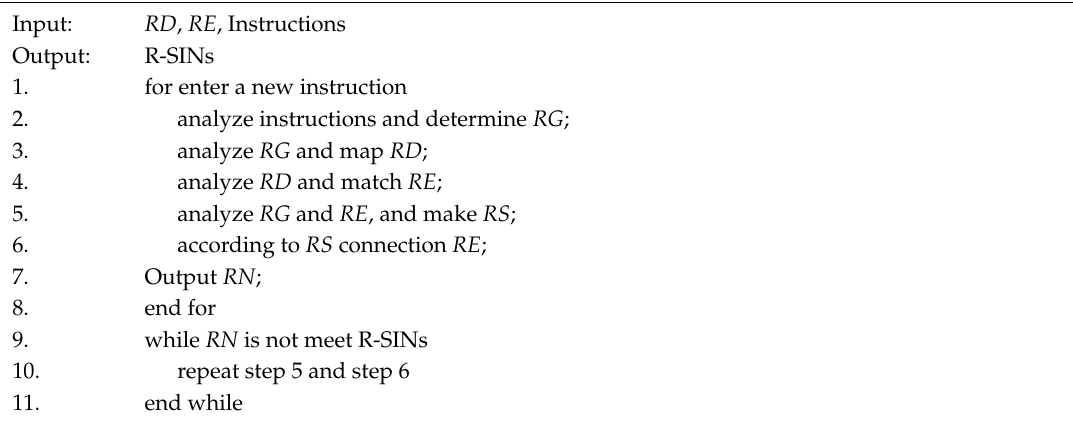
Algorithm 1 The Algorithm Pseudo-Code of the R-SIN Architecture Design, SIN Architecture Reconfigurable